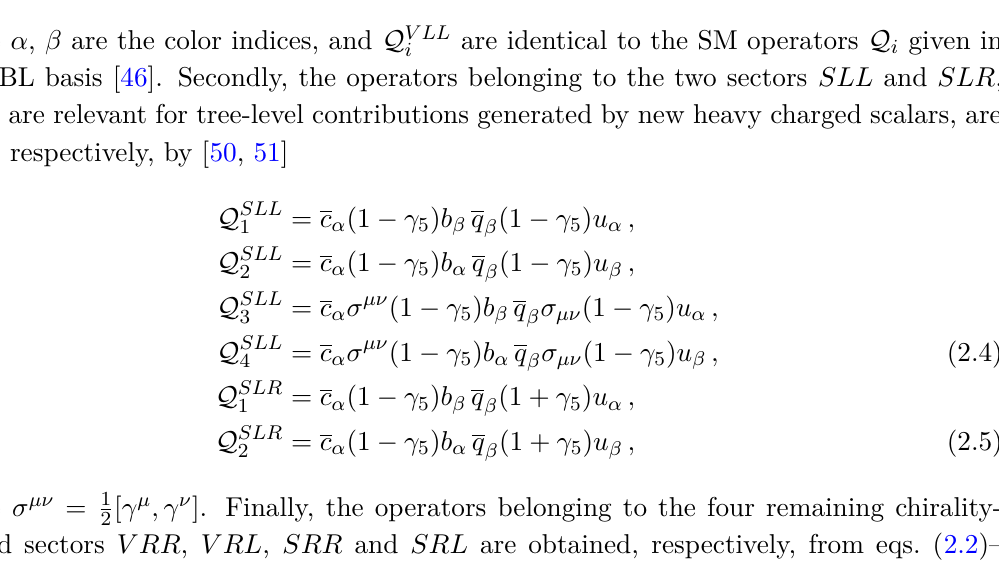
Figure 1 . Feynman rules for the couplings of a colorless charged gauge boson A + (upper) and a colorless charged scalar H + (lower) to an up- ( i α ) and a down-type ( j β ) quark, with the strengths normalized to that of the SM tree-level W + exchange, where g 2 is the SU(2) L gauge coupling and P = 1 (1 ∓ γ 5 ) denote the left- and right-handed chirality L ( R ) 2